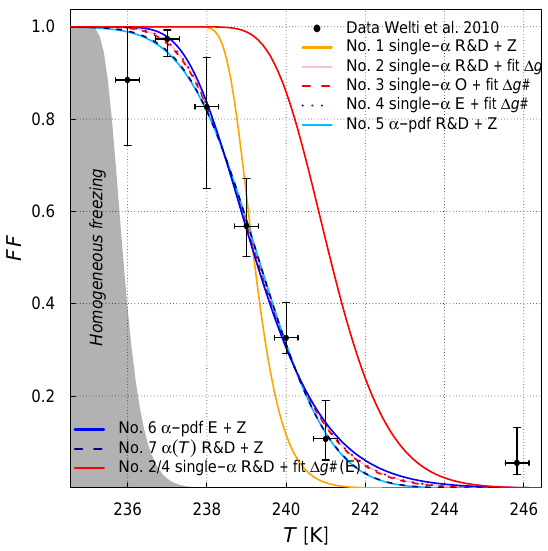
Figure 3. Calculated frozen fraction FF as a function of T for dif- ferent thermodynamic and kinetic parameters in combination with different contact angle schemes for kaolinite with a particle diam- eter of 400nm after a residence time of 10s. More details can be found in Table